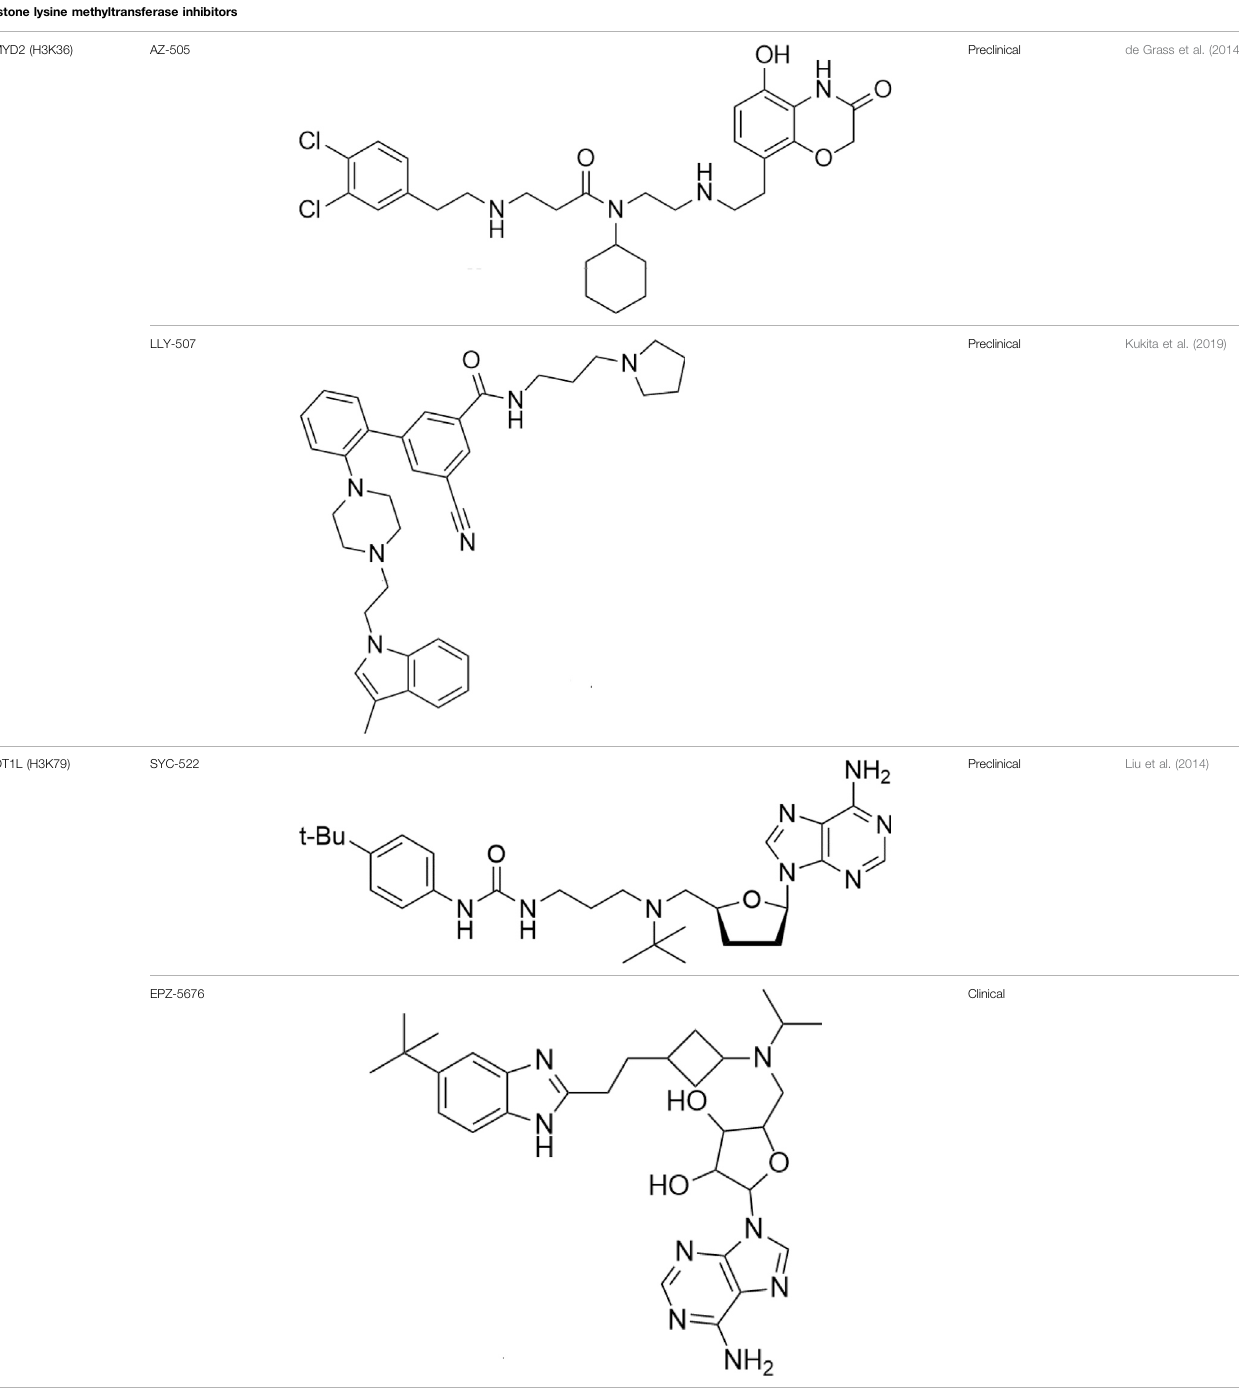
TABLE 2 | ( Continued ) A list of histone lysine methyltransferase inhibitors under different phases of clinical trial and their indication. Histone lysine methyltransferase